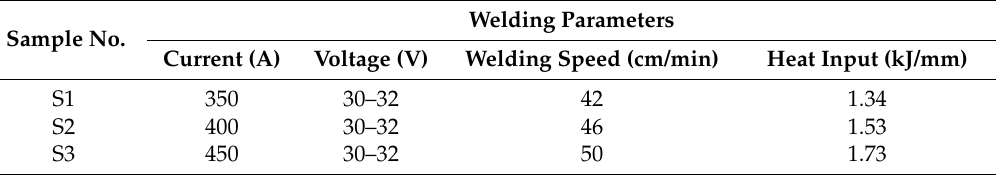
Table 2. The process parameters used in the submerged arc welding.